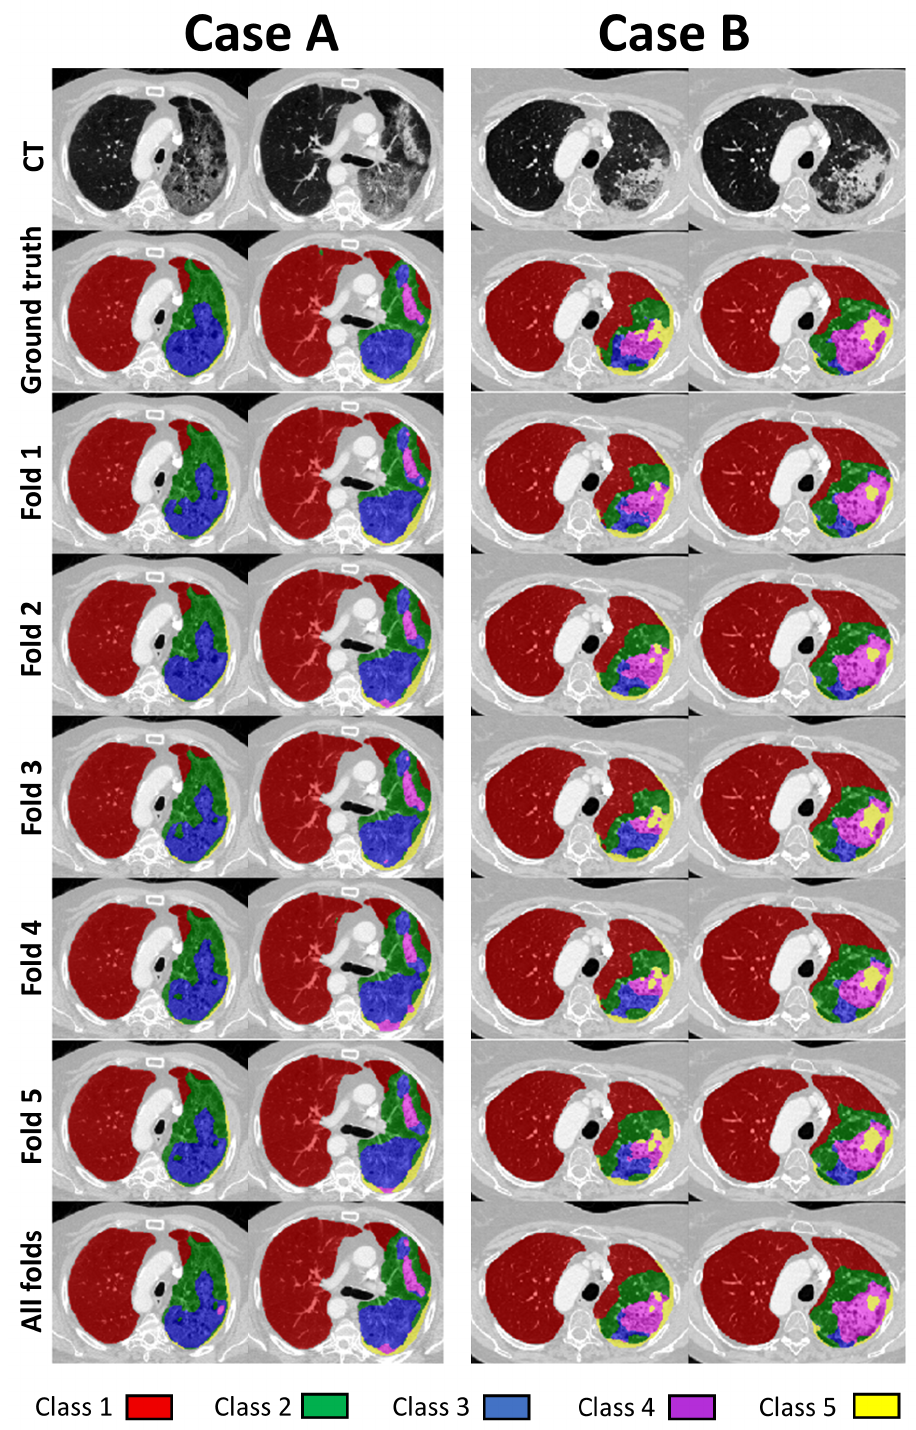
Figure 4. Example of comparison between the folds for two cases (A and B). Overall reasonably good agreement between predicted and ground truth labels can be observed. For areas where they do not agree, discrepancies are usually only by 1 class, and often the predicted labels could be considered reasonable based on the CT